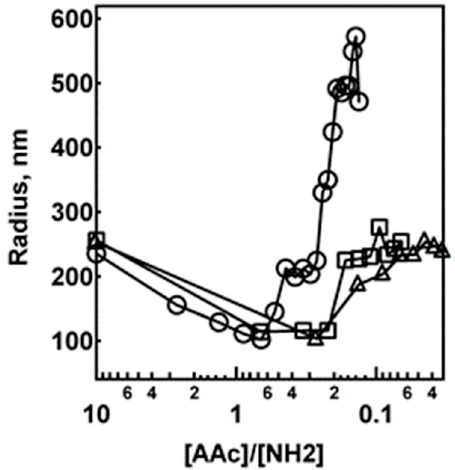
Figure 1. Nanogel titration plots for the titration of 2% BIS, 10% AAc nanogels upon the addition of 0.5 ( ), 2.0 ( ), and 5.0 ( ) L PAH aliquots. The hydrodynamic radius of nanogels measured by DLS.